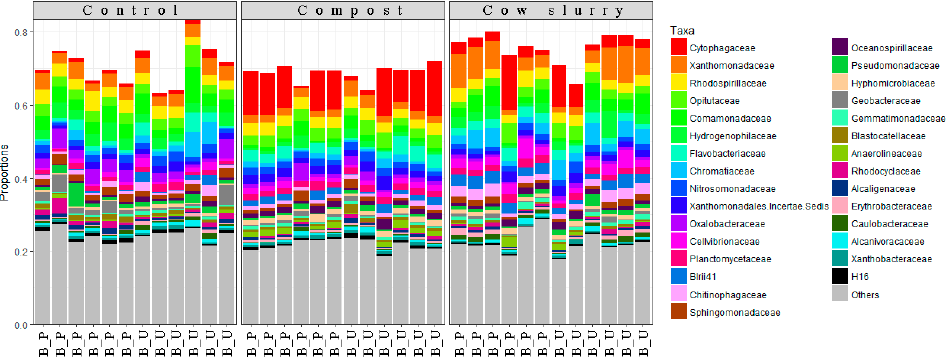
Figure 6. Bar plots representing the distribution of the 30 most abundant bacterial taxa at family level obtained from 16S rRNA metabarcoding. B: bioaugmented; NB: non-bioaugmented; U: unplanted; P: planted soils. Compost: amended with composted horse manure; Cow slurry: amended with dried cow slurry.